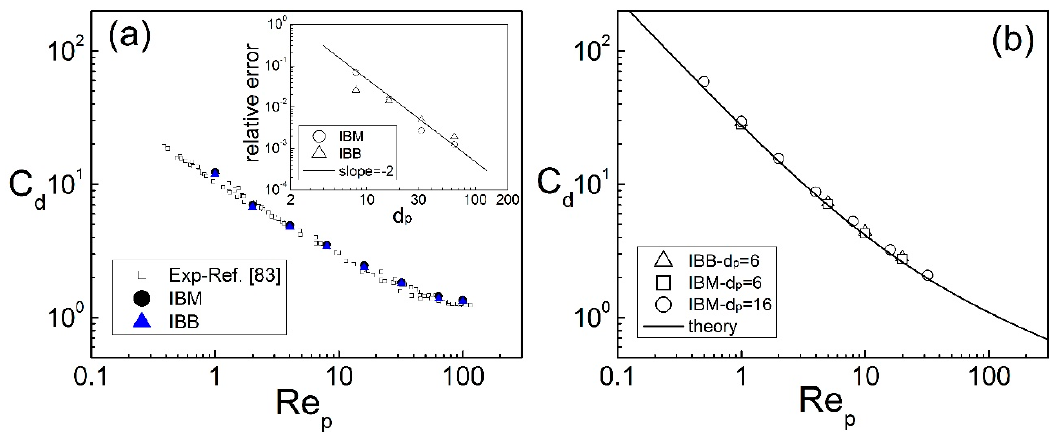
Figure 12. Drag coefficient as a function of particle Reynolds number for ( a ) 2D and ( b ) 3D cases. Figure 12. Drag coe ffi cient as a function of particle Reynolds number for ( a ) 2D and ( b ) 3D